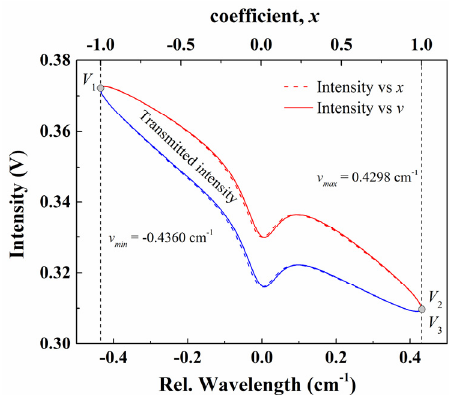
Figure 5. The recovered relationship between the transmitted light intensity and laser wavelength in WM-DAS. The experimental conditions are: CO / N 2 mixture gas, T = 299 K, L = 14.7 cm, Xco = 1.02%, P = 101.3 kPa.